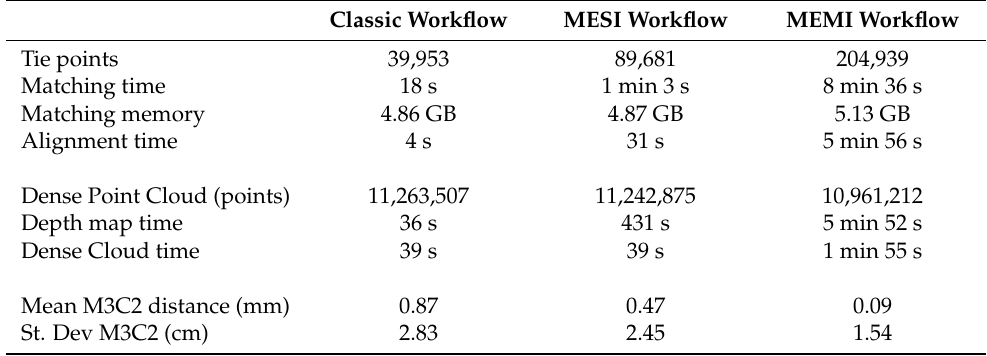
Table 2. Main parameters of the point clouds and M3C2 results obtained in November 2019